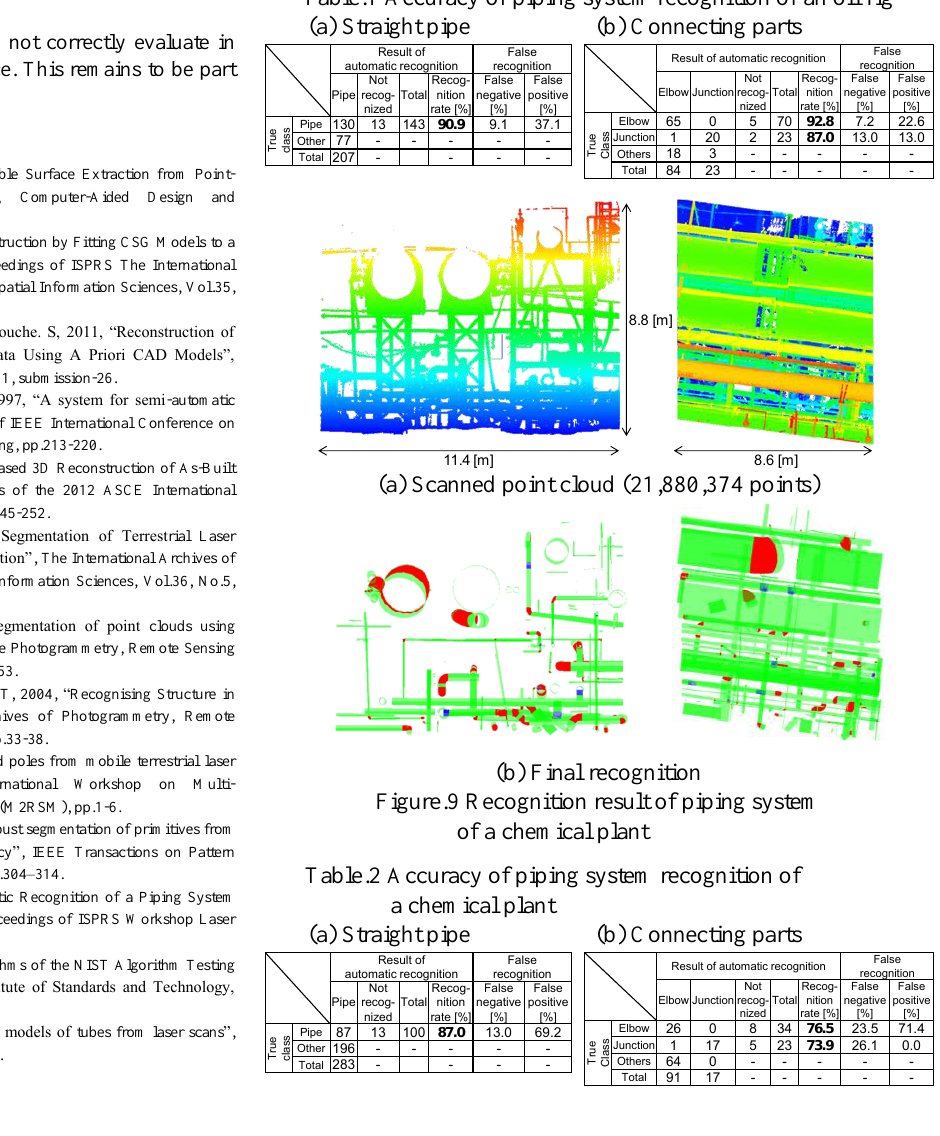
Figure.8 Recognition result of piping system of an oil rig Table.1 Accuracy of piping system recognition of an oil rig